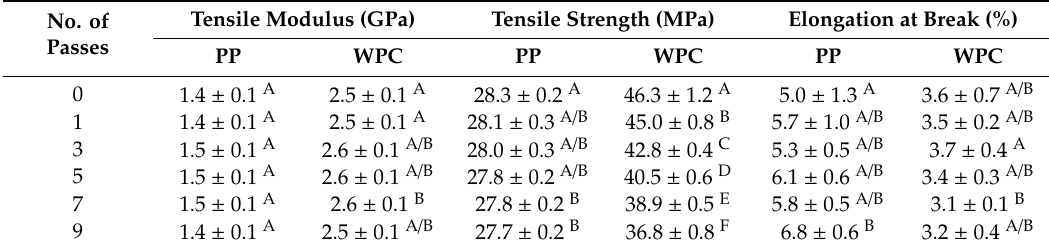
Table 2. Mechanical properties and statistical analysis of neat PP and WPC before and after recycling.